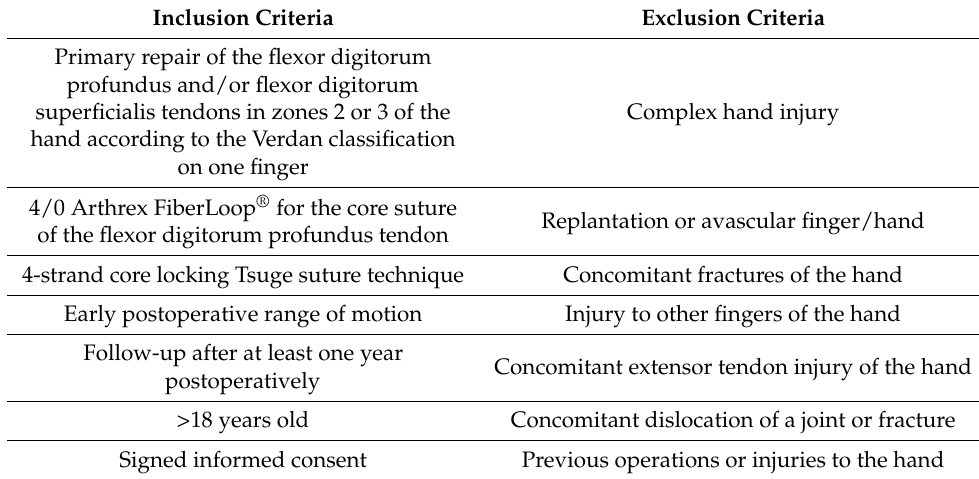
Table 1. Inclusion and exclusion criteria for patients after primary flexor tendon repair for selection to a 2-stage retrospective, randomized follow-up study comparing the rupture rate and functional outcome to the current literature. Inclusion Criteria